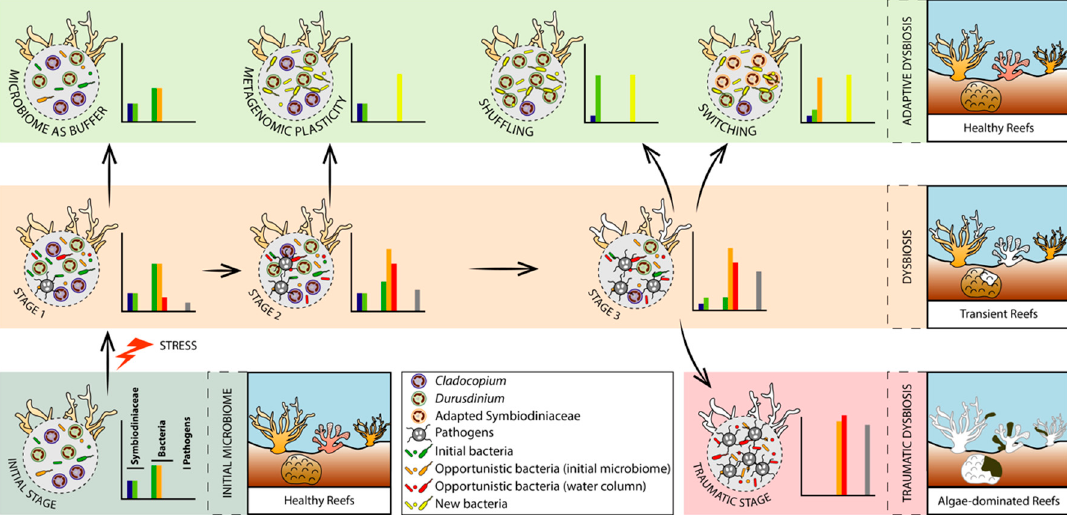
Figure 3. Holobiont dysbiosis phases associated with their coral bleaching states. The diagram illustrates an environmental stressor (increased temperature) inducing the disruption of the initial microbiome, leading to a dysbiosis state (stage 1) where the coral holobiont remains healthy (no sign of bleaching) despite the increase in the abundance of native opportunistic bacterial species and the settlement of invading pathogens and other opportunistic bacteria from the surrounding environment. The microbiota could act as a bu ff er and revert to its initial bacterial composition, representing an adaptive dysbiosis; or the environmental stressor could exceed the bu ff er capacity of the microbiota leading to another dysbiosis state (stage 2), where opportunistic bacteria and pathogens will slowly replace the initial microbiota, while the coral holobiont still remains healthy. Metagenomic plasticity, here referring to the addition of novel bacterial species and functions (but changes in relative abundances of native bacteria can also occur), either leads to another adaptive dysbiosis; or the environmental stressor exceeds once again the bu ff er capacity of the microbiota leading to another dysbiosis state (stage 3), where transient bleaching can be observed. Corals can revert to a healthy state by recovering a better suited Symbiodiniaceae assemblage, either by adjusting the relative abundance of native species from a low-background (shu ffl ing), here referring to the increase in heat-tolerant Durusdinium species; or by recruiting exogenous species from the surrounding environment that are better adapted to elevated temperature (switching). If the stressor causes an abrupt change in the reef environment or persists for long periods, the adaptive dysbiosis will not act as a mechanism of environmental adaptation. In that case, the traumatic dysbiosis occurs with the permanent loss of the Symbiodiniaceae partners leading to coral death, and ultimately to a reef ecosystem dominated by algae and cyanobacteria (phase shifts). Each dotted circle represents the microbiome of a coral at each of the dysbiosis stages described, while the bar plots illustrate the declining number of “good microorganisms” and the increasing number of “bad” ones within the coral microbiome at each of the dysbiosis stages. The number and size of the Symbiodiniaceae and microbes within the coral tissues has been modified for illustration